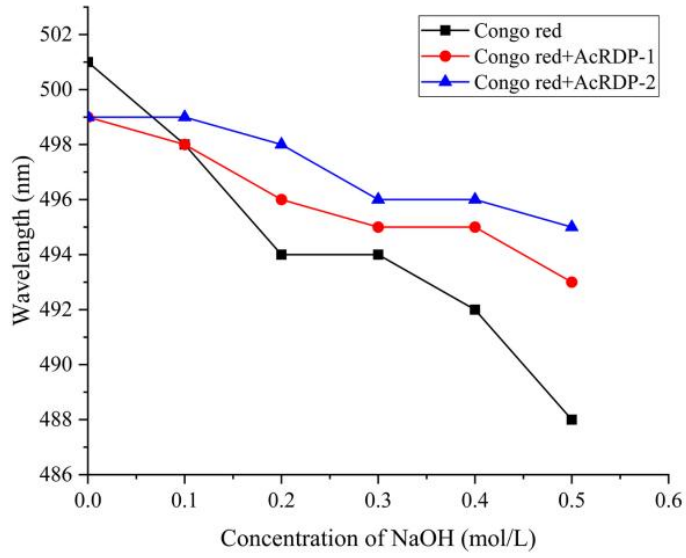
Figure 6. Changes in the absorption wavelength maximum of Congo red with AcRDP-1 and AcRDP-2 complexes at various concentrations of NaOH.